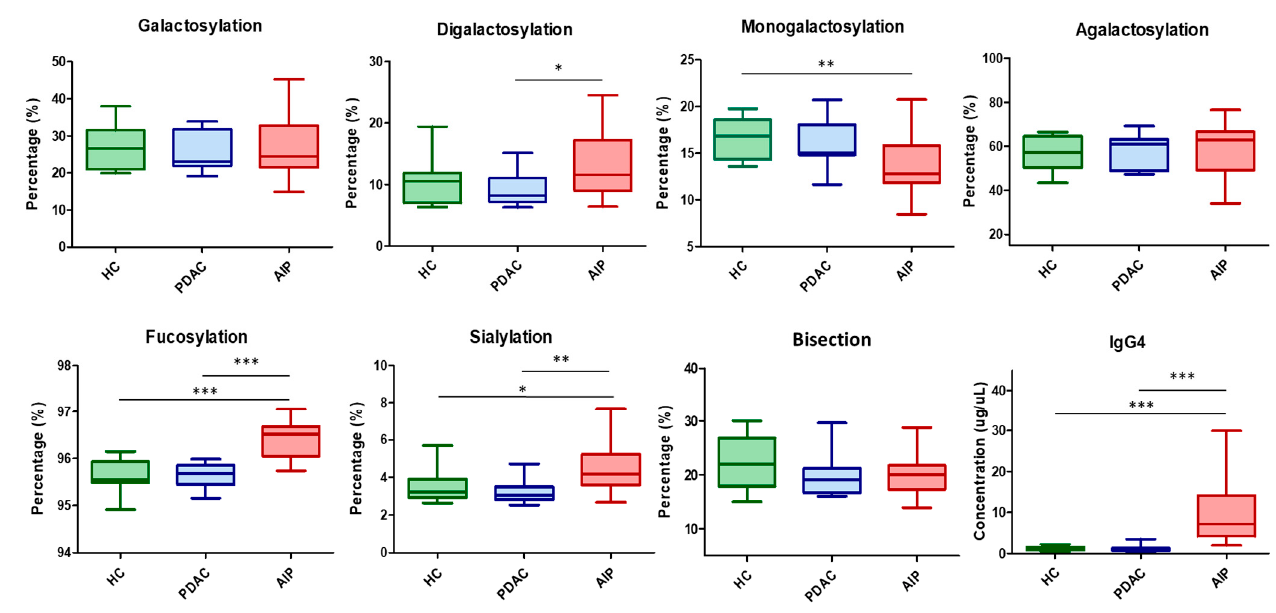
Figure 5 . IgG4 showed different glycosylation patterns between groups. HC, healthy controls; PDAC, pancreatic ductal adenocarcinoma; AIP, autoimmune pancreatitis. * represents p < 0.05; ** represents p <0.01; *** represents p <0.0001 for Mann–Whitney statistical analysis.